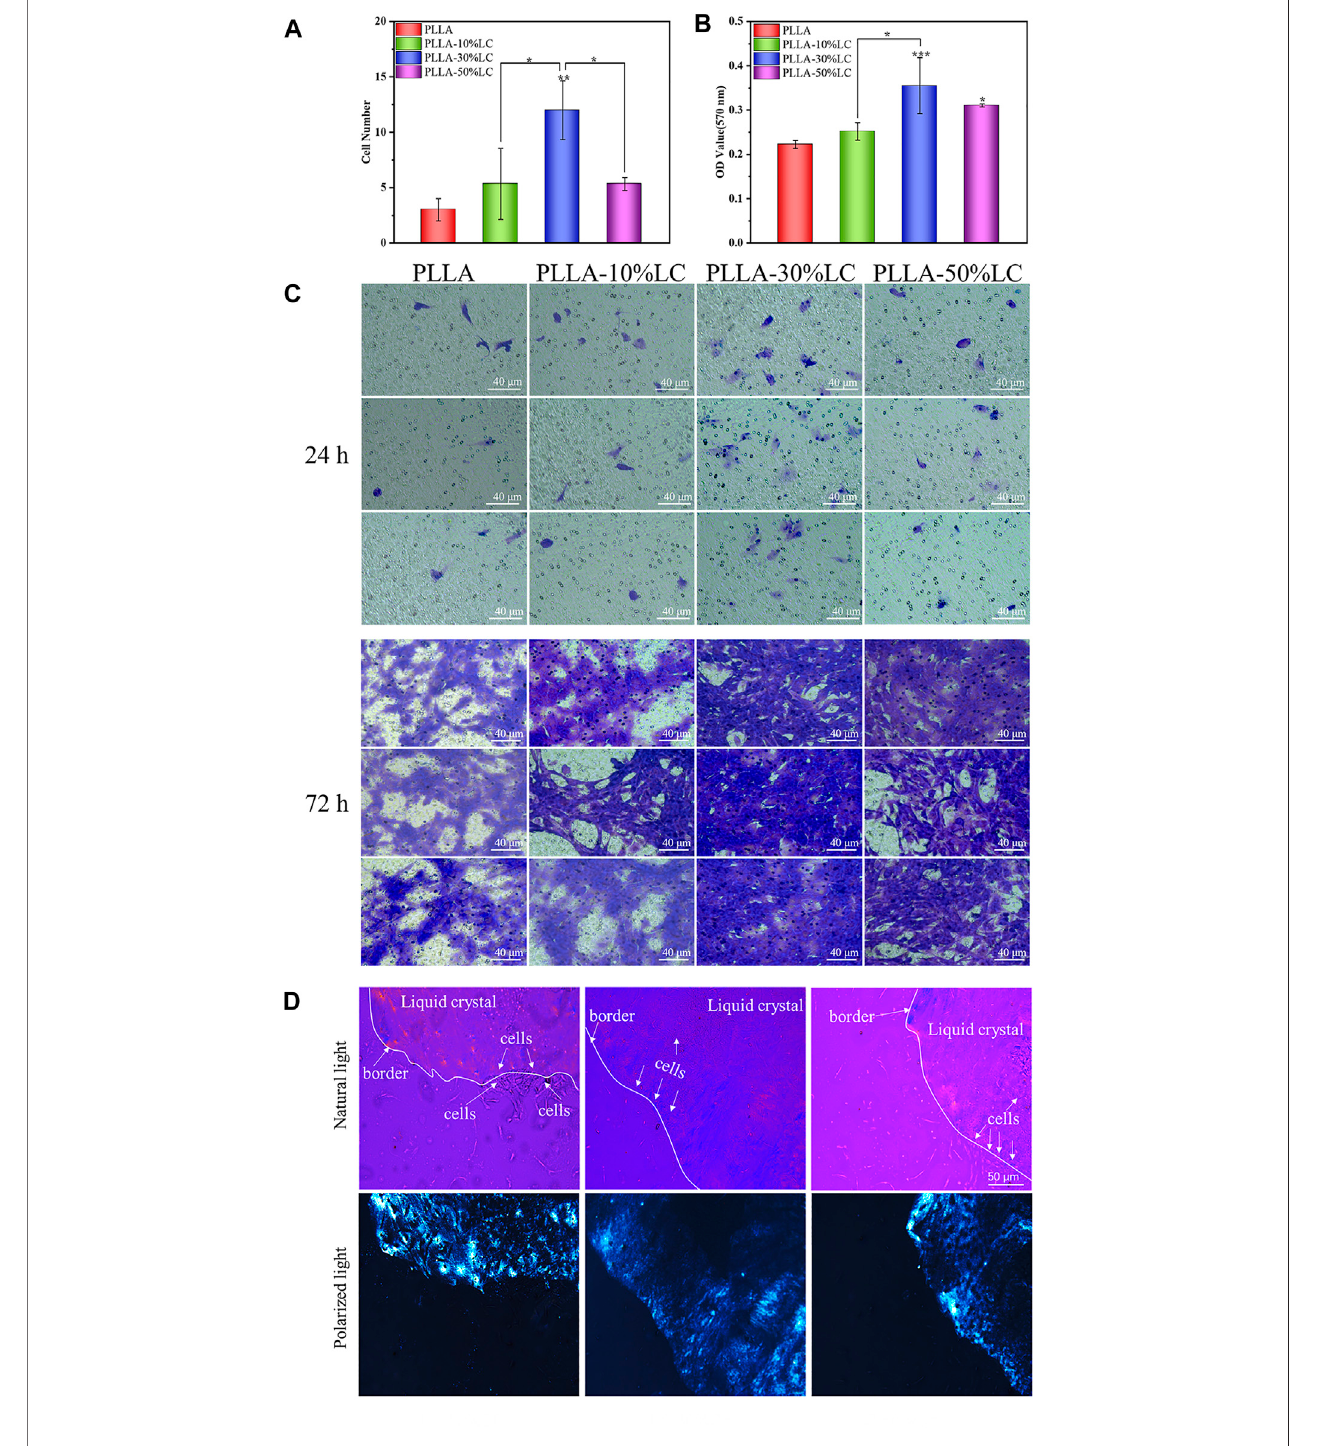
FIGURE 4 | (A) Cell count of osteoblasts migrating in the transwell chamber for 24 h; (B) quantitative analysis ofosteoblasts migrating in the transwell chamber for 72 h; (C) crystal violet staining of osteoblasts migrating in the transwell chamber for 24 and 72 h; and (D) distribution of cells on LC-30% CP.